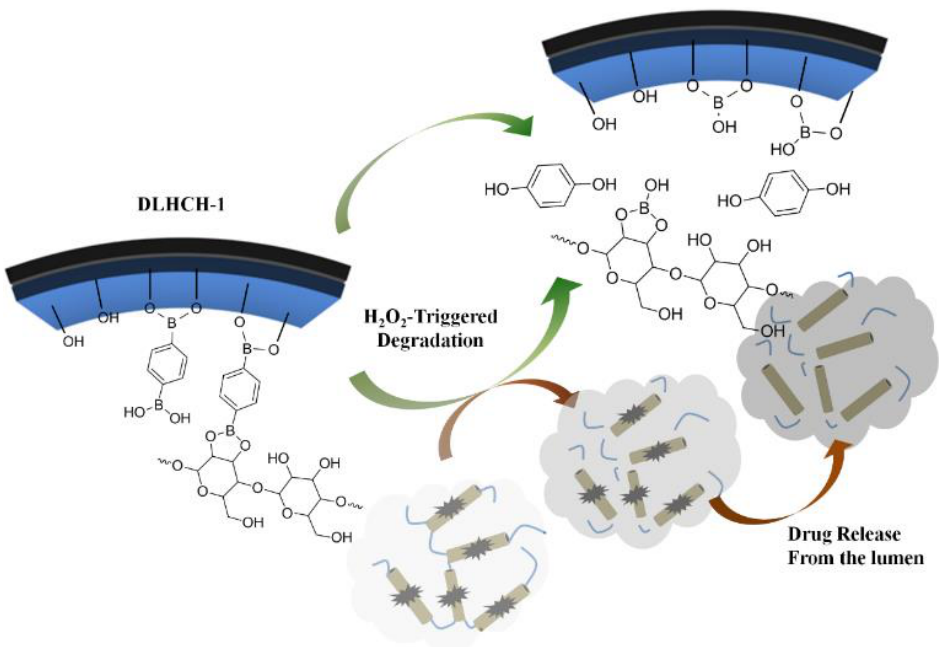
Figure 1. The H 2 O 2 -responsive release mechanism of the 1,4-phenylenediboronic acid-crosslinked hydrogels reported by our group (Reprinted/adapted with permission from Ref. [50]. Copyright year: 2022, copyright owner’s name: Hailei Zhang) .